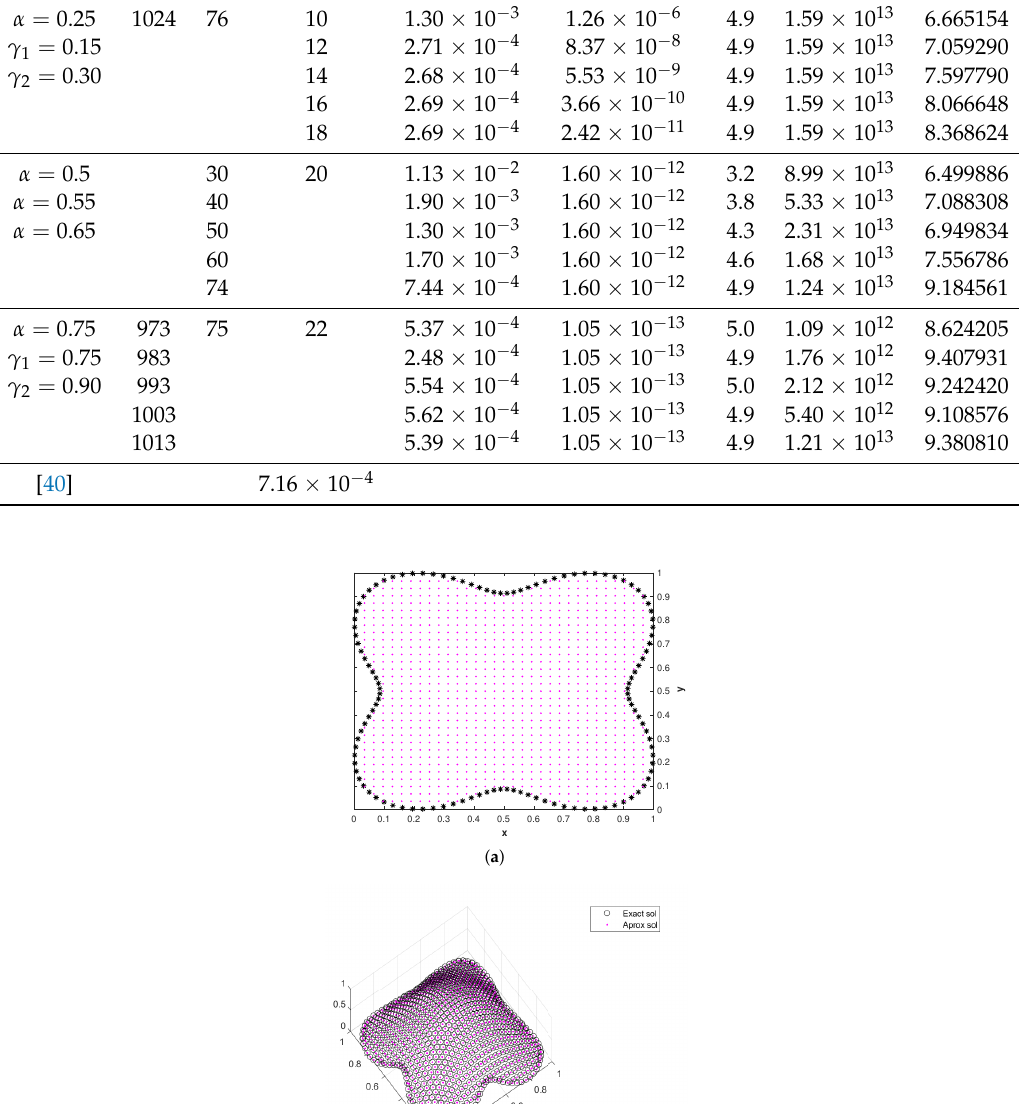
Table 2. Numerical results for the FPIDEs in nut-shaped domain.